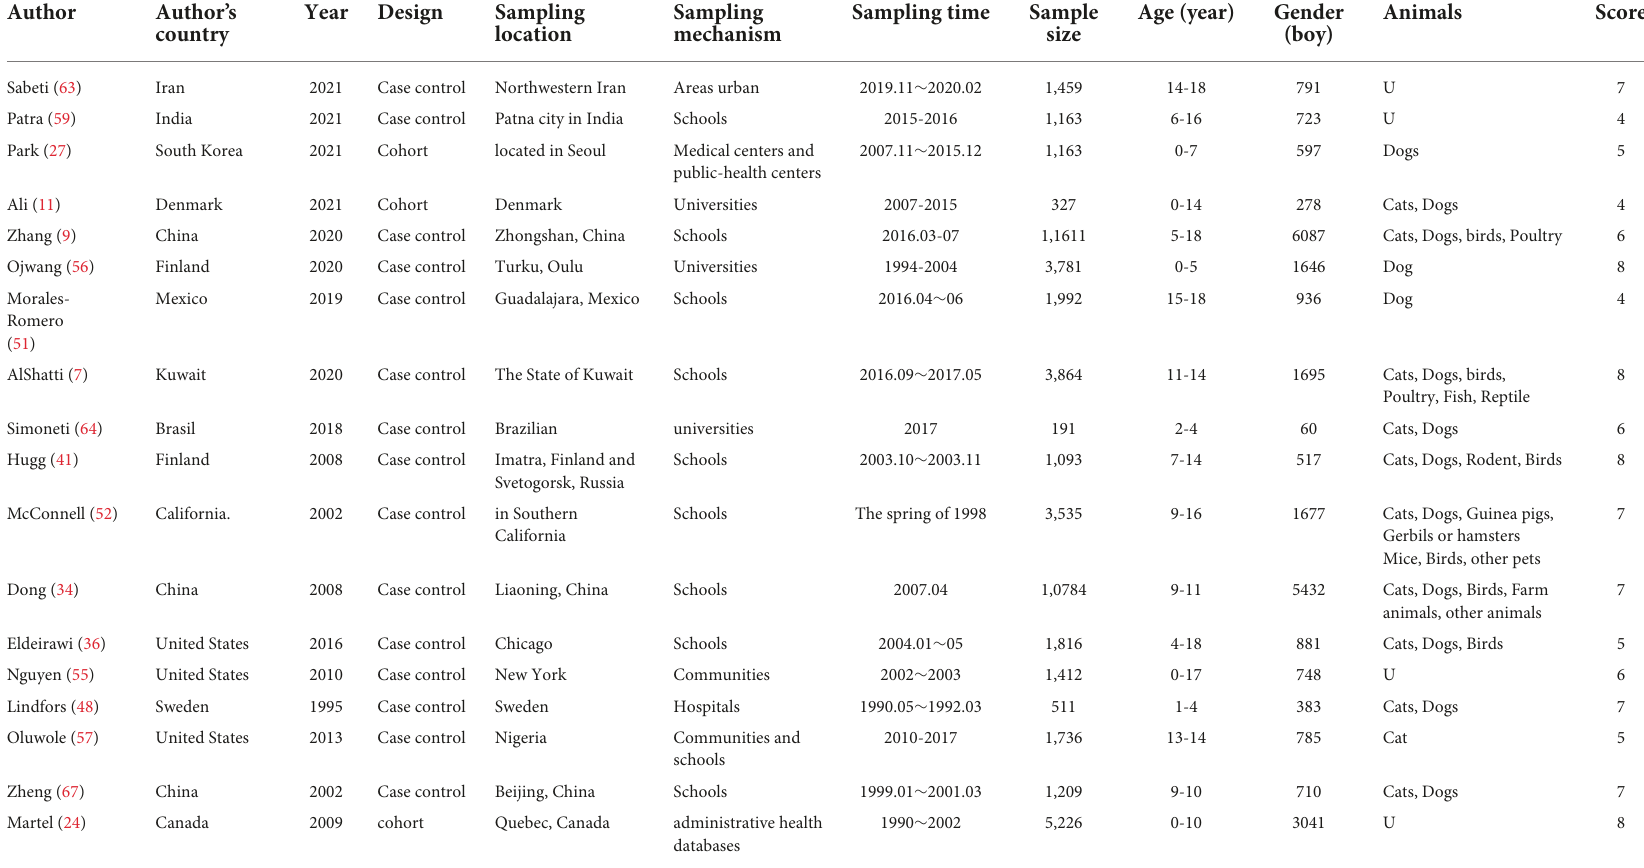
TABLE 1 Characteristics of the included studies and the assessment of quality of the studies according to the Newcastle-Ottawa Scale